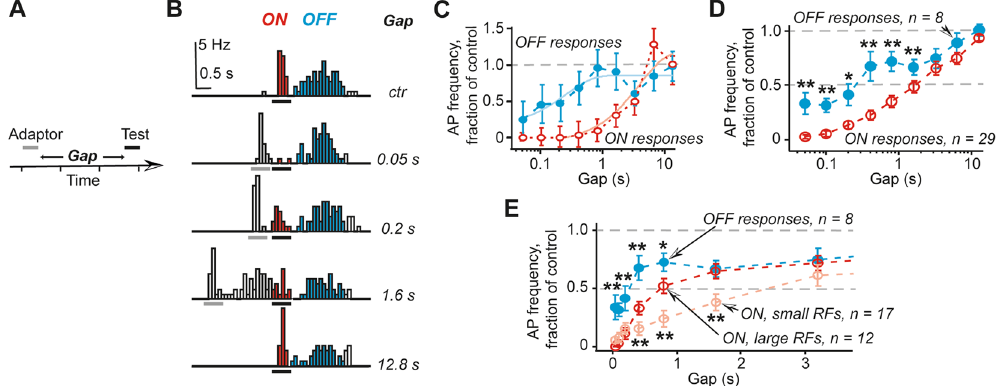
Figure 2. Recovery analysis reveals differences between ON and OFF responses and the units with large and small RFs. ( A ) Schematics of the stimulation protocol used in these tests, the protocol was repeated each 30 s. ( B ) Non-subtracted PSTHs of a representative unit are shown for responses to stimuli presented without the adaptor stimulus (control) and following 0.05 s, 0.2 s, 1.6 s and 12.8 s gap after the adaptor stimulus. ( C ) The recovery of ON (blue circles) and OFF (red circles) responses of the unit shown in ( B , D ) Summary of all tested units. ( E ) Summary of ON response recovery for small RF (( > 20°) and large RF ( > 20°) units, OFF response recovery was the same for all units and it is added for comparison. Note that in E the time scale is linear but not logarithmic as in ( C , D ). In ( D , E ) asterisks indicate statistically significant differences between ON and OFF responses in D and between OFF and large RF or large and small RF units in E for the same gap duration: ** indicates p < 0.01 while * corresponds to p <